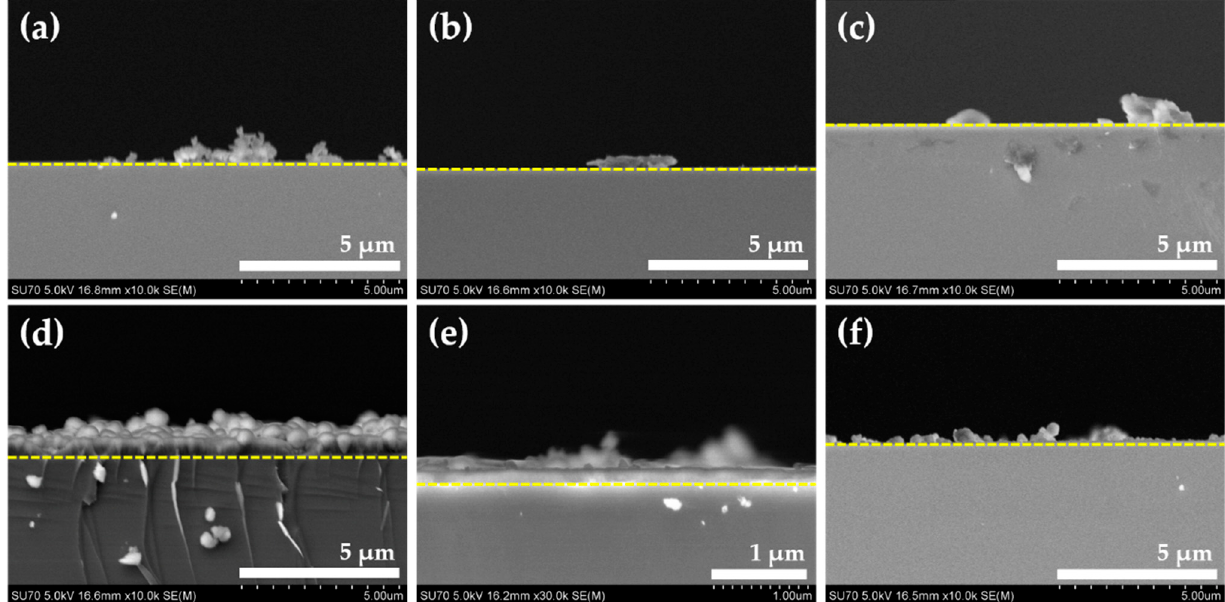
Figure 2. Cross section views of FESEM images of the silicon oxide film deposited on the Si substrate using a nozzle quartz tube with N 2 flow rates of ( a ) 0 sccm, ( b ) 50 sccm, ( c ) 500 sccm, ( d ) 5000 sccm, ( e ) 15,000 sccm, and ( f ) 25,000 sccm.